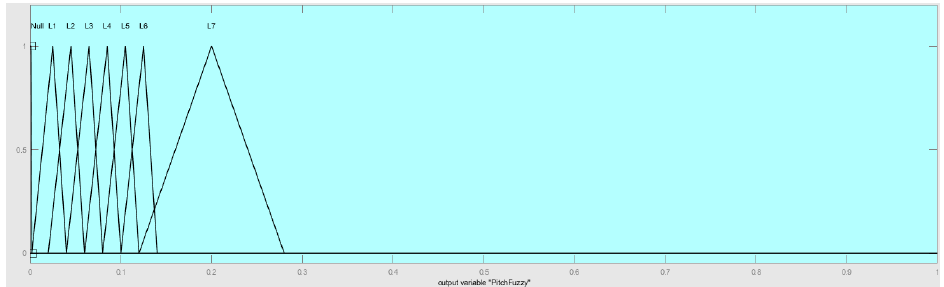
Figure 10. Membership functions of the pitch reference output.